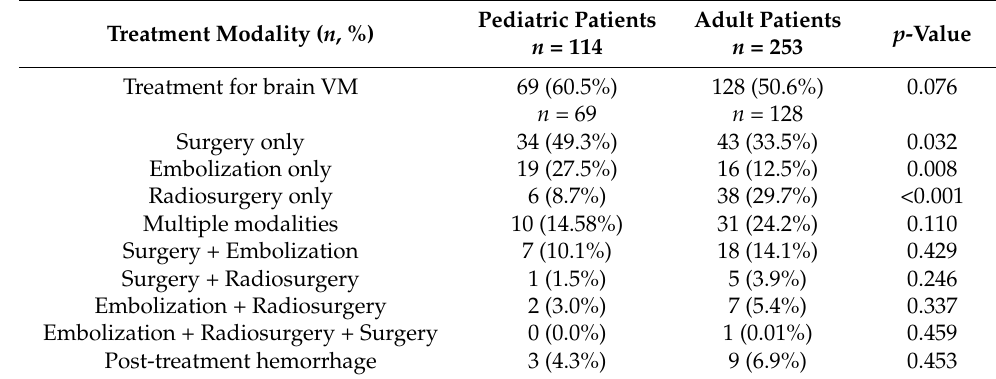
Table 2. Treatment Modalities for Pediatric and Adult patients with HHT related brain